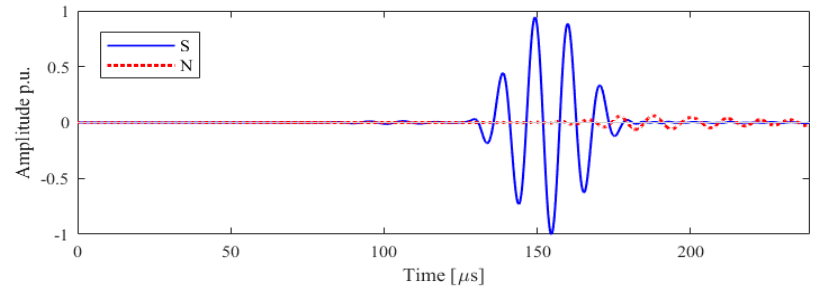
Figure 15. Configuration A’ results of the in-plane (blue), ‘S’, and out-of-plane, ‘N’, (red) velocities along the line orthogonal to the line of vibration. Normalized data are